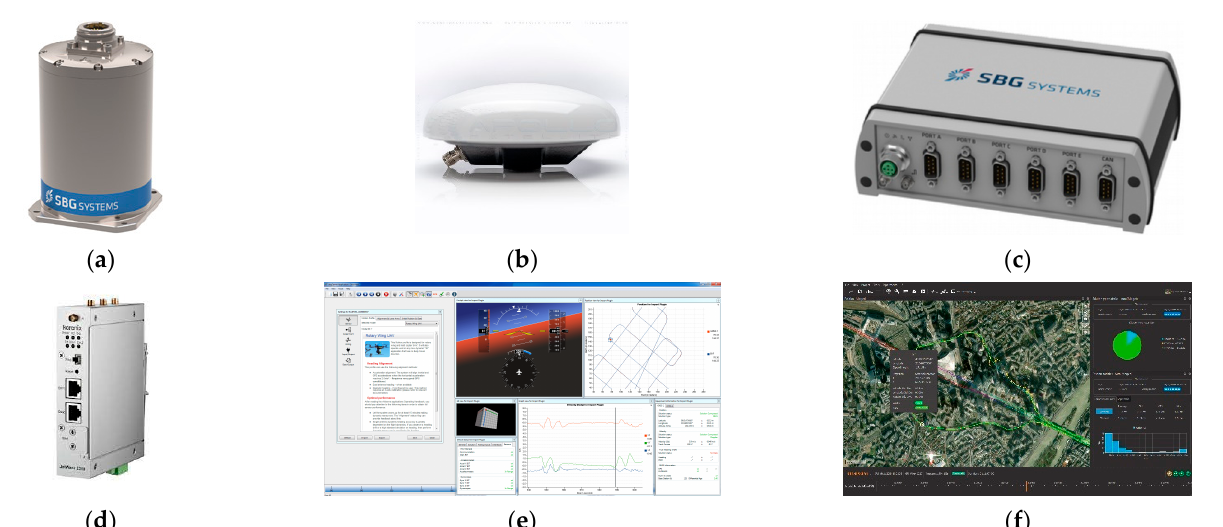
Figure 1. Components of the GNSS/INS system, model Ekinox2-U, by the SBG Systems: ( a ) IMU, ( b ) GNSS antennas, ( c ) SplitBox computer system, ( d ) modem enabling the reception of RTK/RTN corrections, ( e ) sbgCenter software and ( f ) Qinertia software [75].